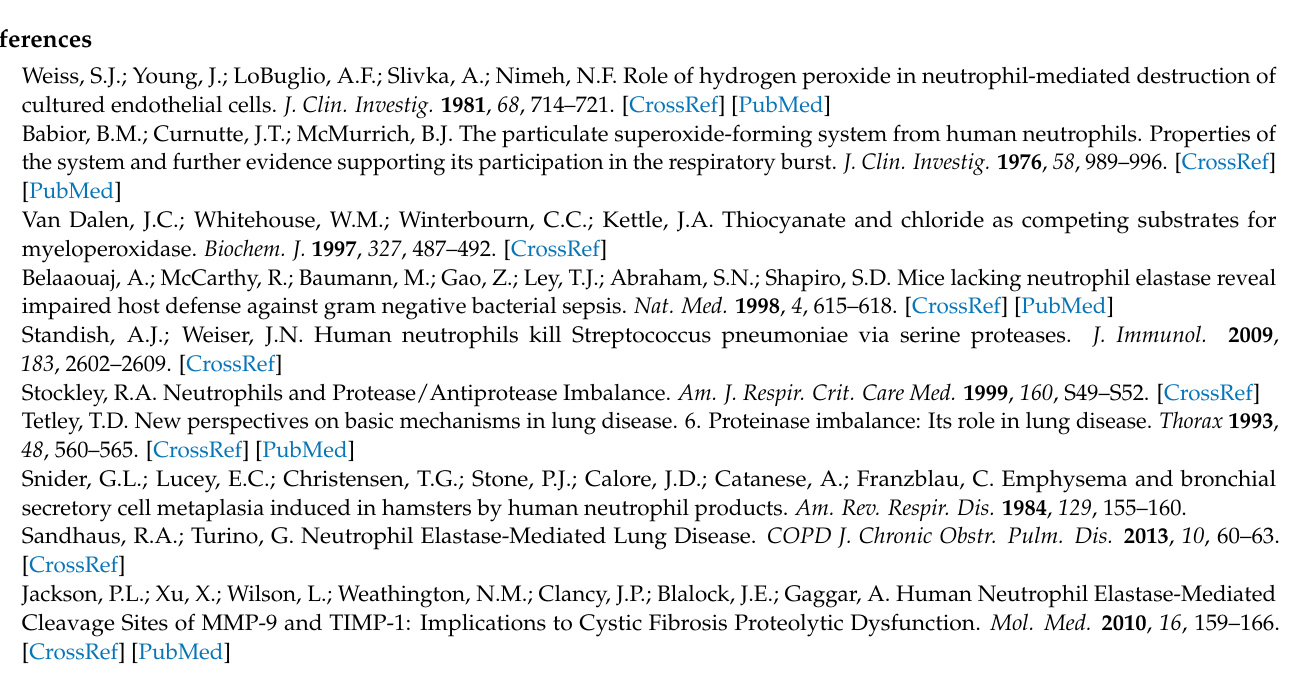
Supplementary Materials: Figure S1. Trajectories for molecular dynamic simulation of HNE in complex with RMAV-H peptide aldehyde and its oxidized variants. Figure S2. SDS PAGE analysis of HNE supplied by Elastin Products Company. Table S1. Calculated and observed masses of candidate peptide-pNA substrates and peptide aldehyde inhibitors. All masses are listed in